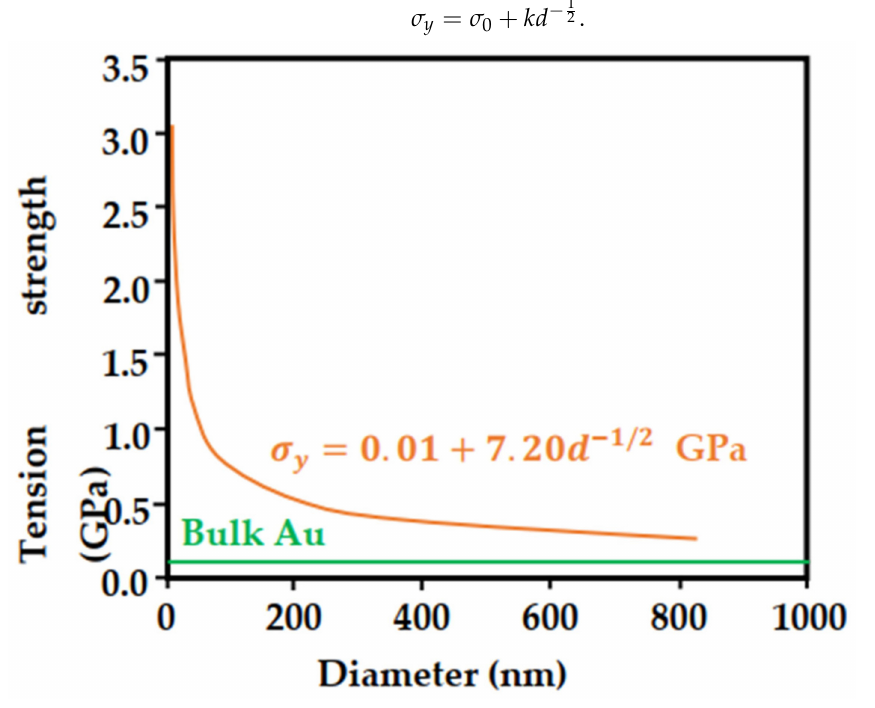
Figure 11. The relationship between the tensile strength of Au nanopillars and the diameter of nanopillars. Among them, σ y and σ 0 are the yield stress and internal friction, k is the Hall–Petch constant, and d is the size of the grain, which can generally be understood as the character- istic